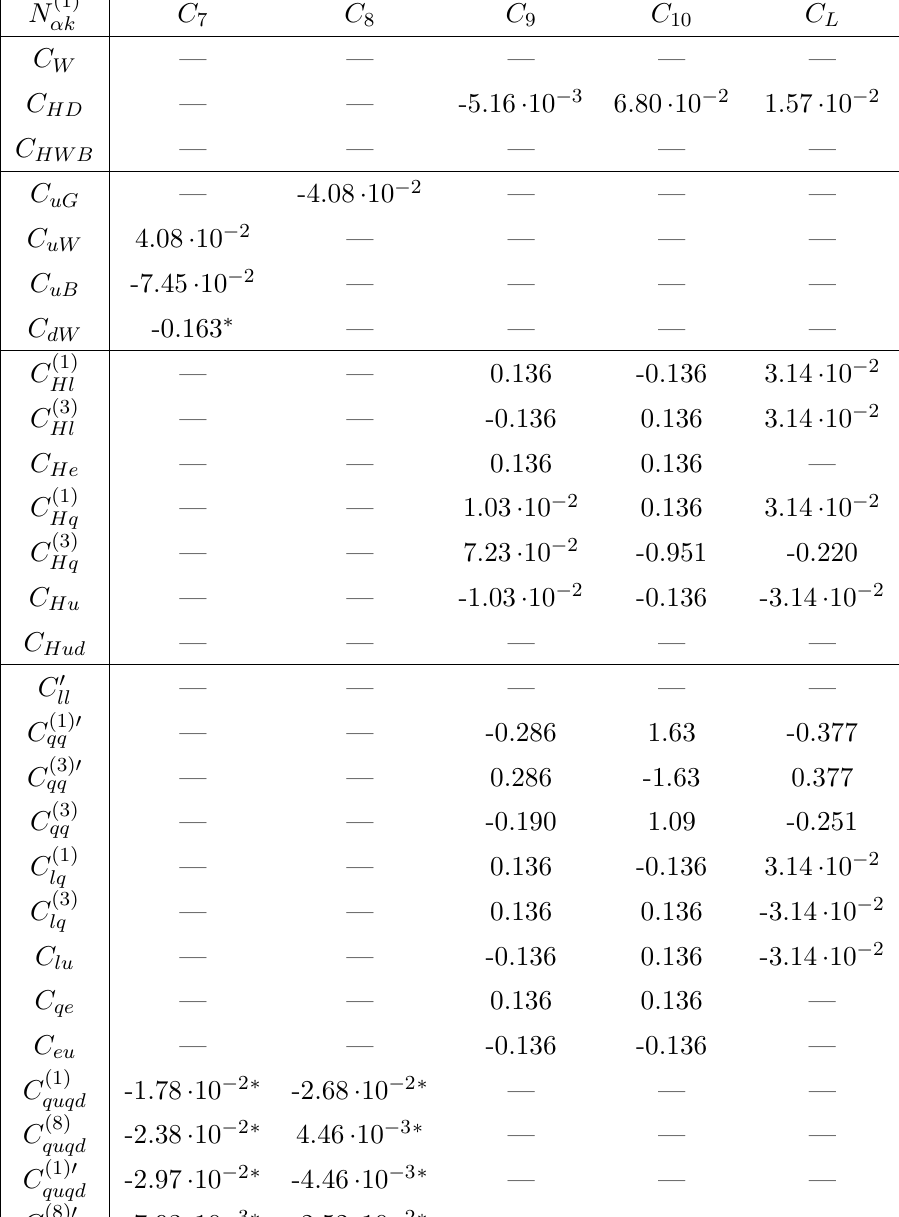
— — — Table 3. Numerical values of the coefficients N (1) of the matching equation eq. (3.5). Note that αk the matching to C 1 , mix , C 1 and C 2 does not have any divergent diagrams so the corresponding N (1) coefficients are all zero (and are not listed here). All results are quark-flavour universal αk ( C α ≡ C bs = C bd = C sd ), except for results indicated by an asterisk ( ∗ ), for which only C bd j α is α α α meant ( d j = s, d